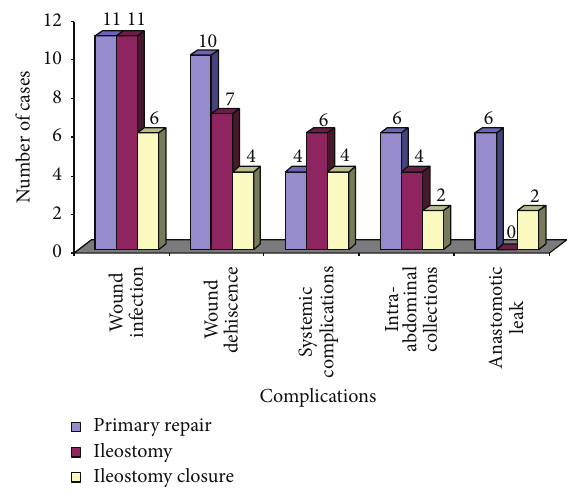
Figure2:Complicationsinprimaryrepair,ileostomy,andileostomy